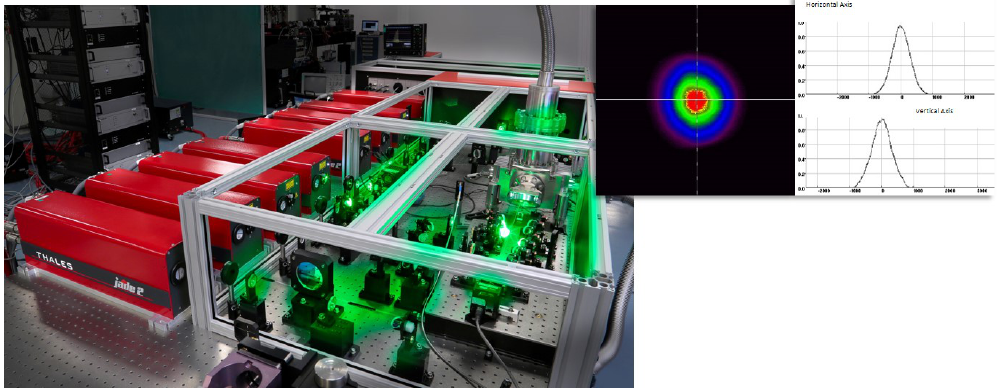
Figure 5: The block of eight pump lasers and the second amplification stage. The first pump laser is used to pump the first amplification stage, while the remaining seven pump lasers are employed for pumping the cryo-cooled Ti:Sapphire crystal of the second amplification stage. The typical beam profile of a Jade 2 pump laser is shown on the right.